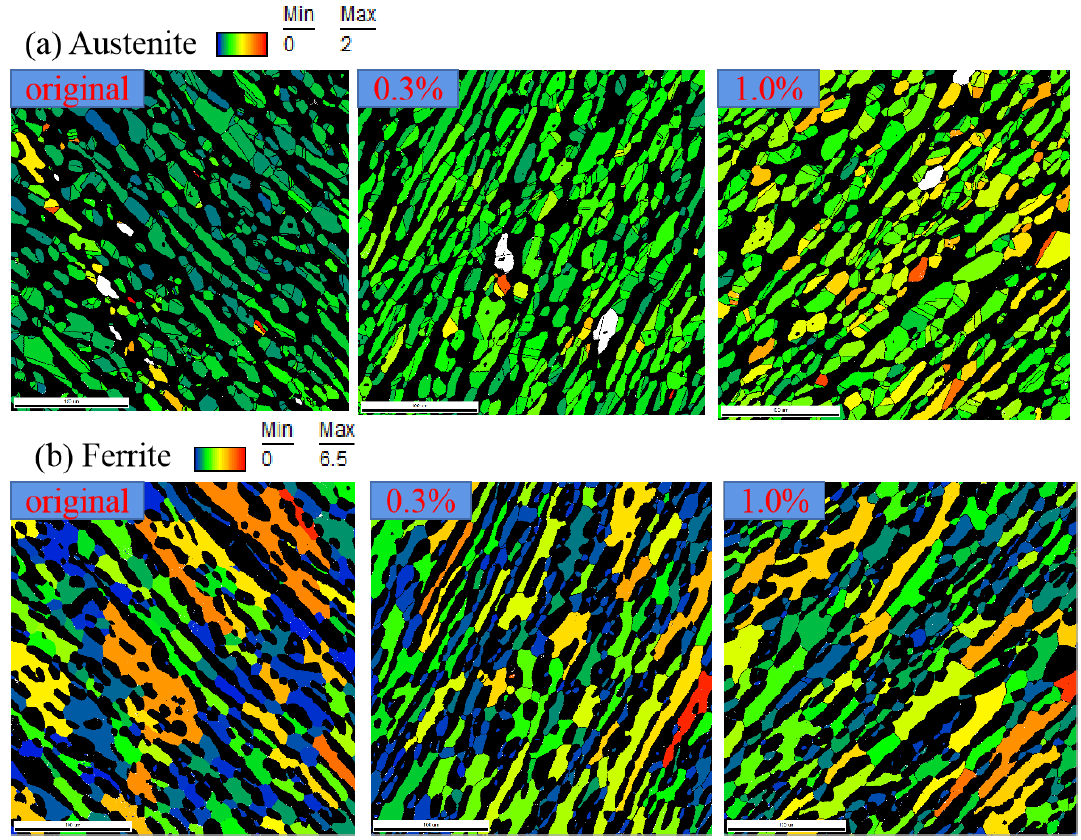
Figure 9. Distribution of GAM within two constitutive phases for 2205 under different strain amplitudes: ( a ) austenite and ( b ) ferrite.